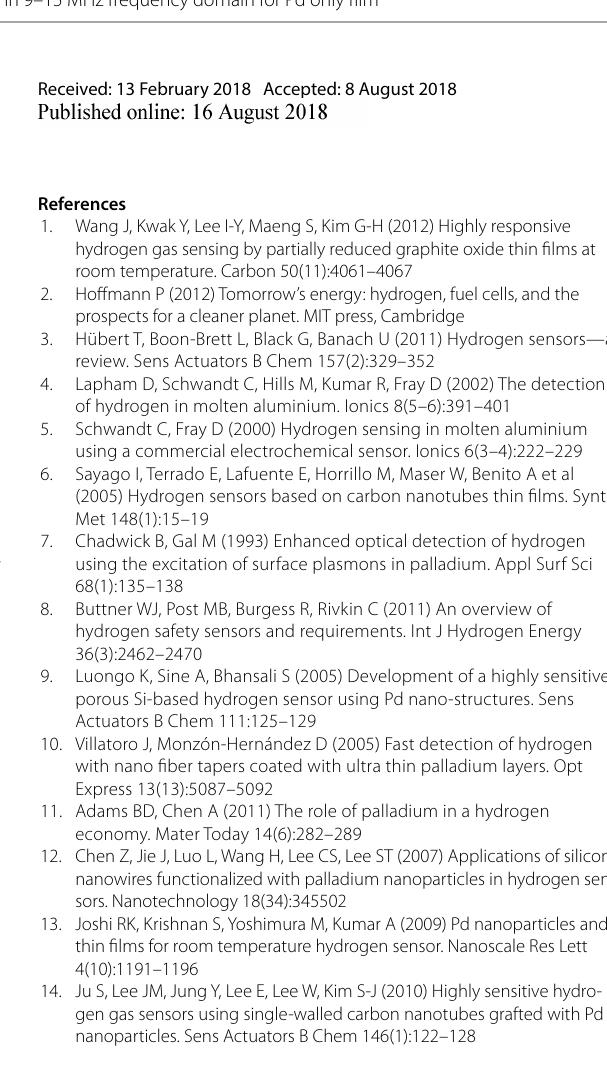
Fig. 15 a Impedance vs frequency and b impedance vs H 2 percentage in 9–15 MHz frequency domain for Pd only